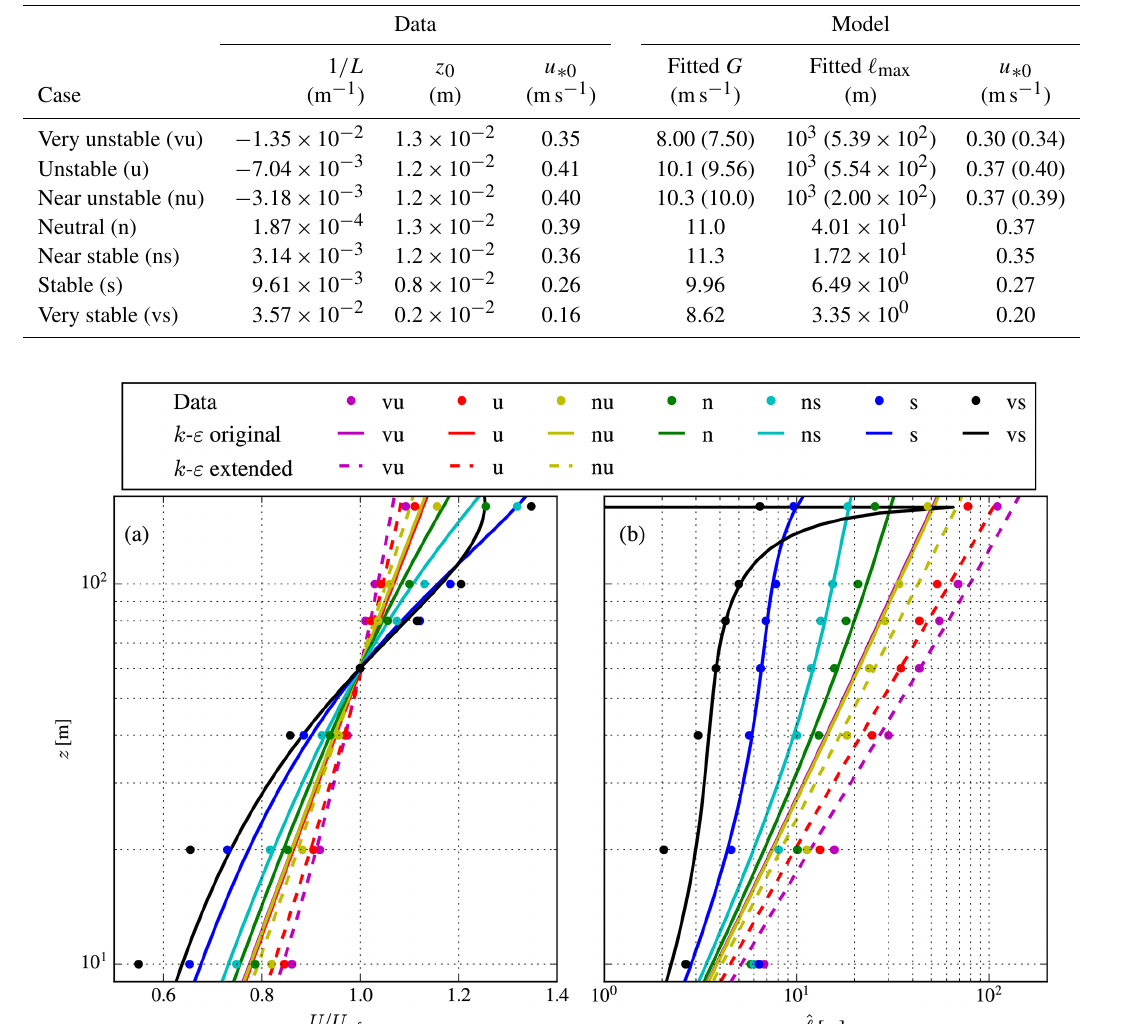
Table 2. ASL validation cases. Fitted G , fitted (cid:96) max , and modeled u ∗ 0 in parentheses represent values for the extended model.